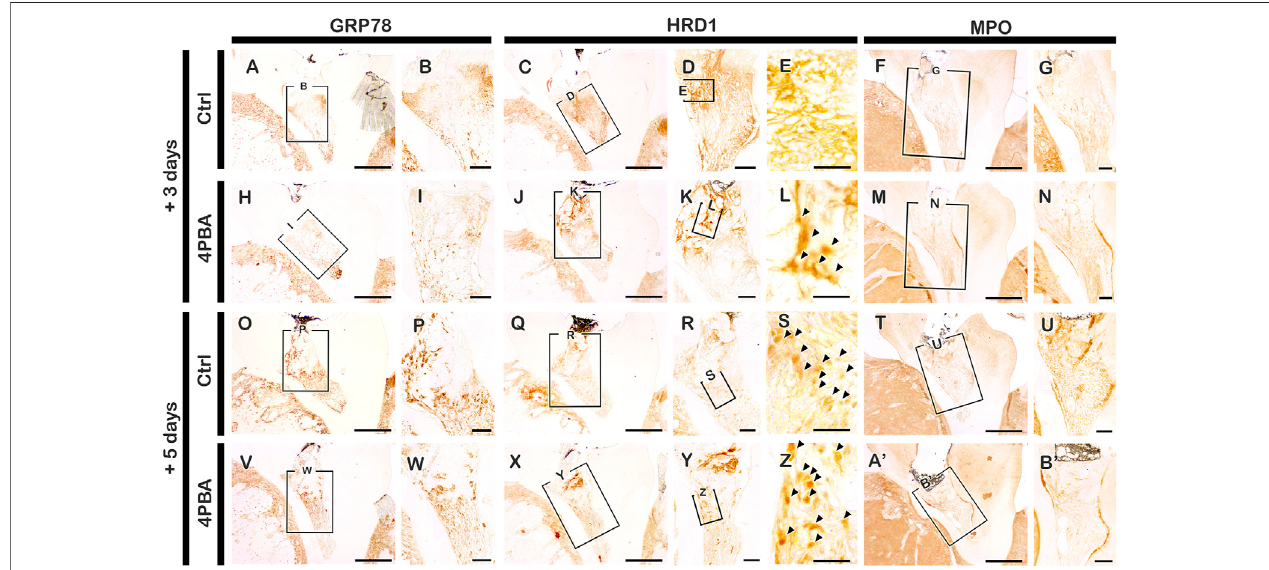
FIGURE 1 | Immunohistochemistry staining with GRP78, HRD1 and MPO after 3 and 5 days pulp access preparation. Arrowhead indicates nucleic localization patterns of HRD1 immunostaining (E, L, S, Z). Boxes in A, C-D, F, H, J-K, M, O, Q-R, T, V, X-Y, A ′ indicate enlarged view. Scale bars: A, C, F, H, J, M, O, Q, T, V, X, A ’